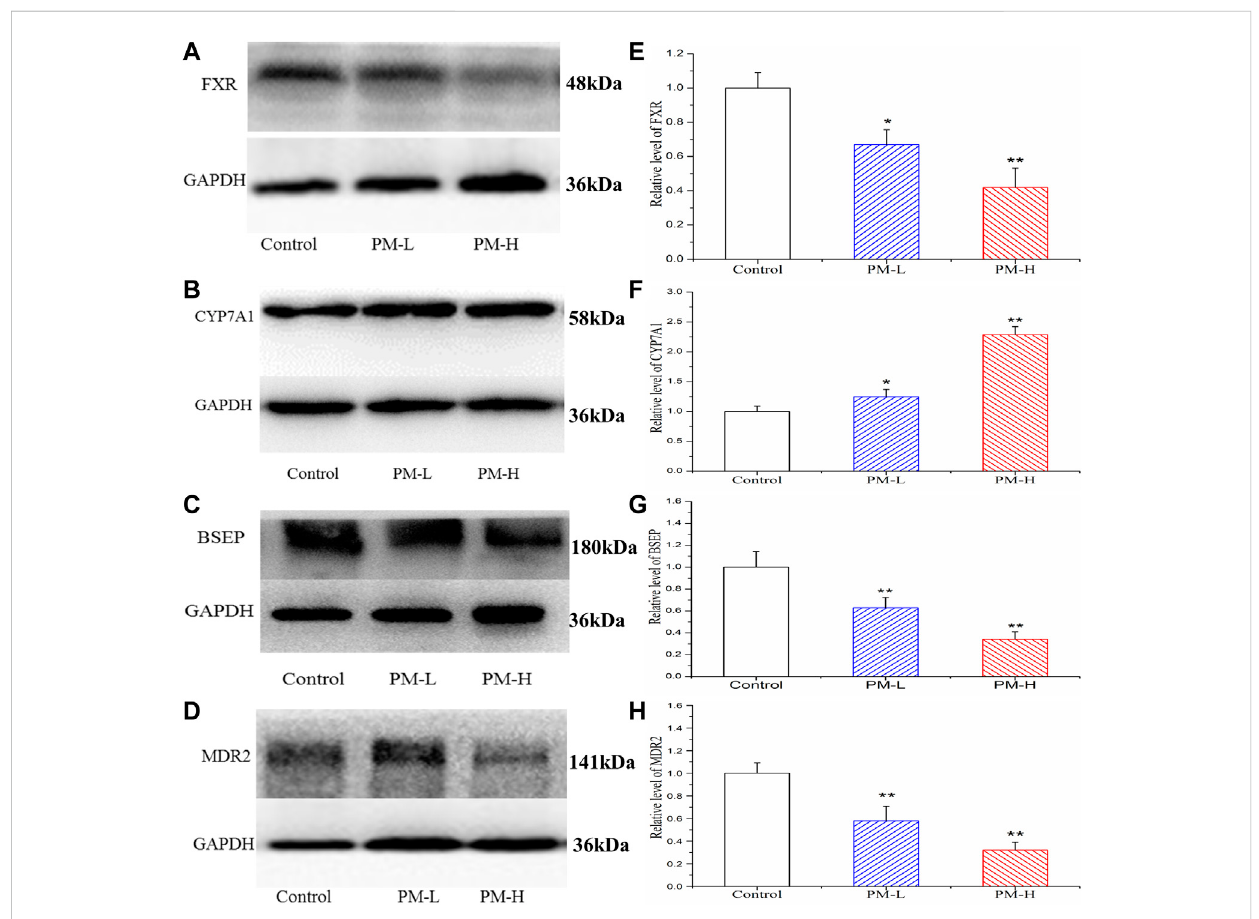
FIGURE 8 Effect of the protein expression of FXR (A, E) , CYP7A1 (B, F) , BSEP (C, G) and MDR2 (D, H) in mice after PM-L and PM-H treatment for 8 weeks. Quanti fi cation of the protein expression was performed by densitometric analysis of the blots following normalization to GAPDH expression. (mean ± SEM, n = 3, * p < 0.05, ** p <